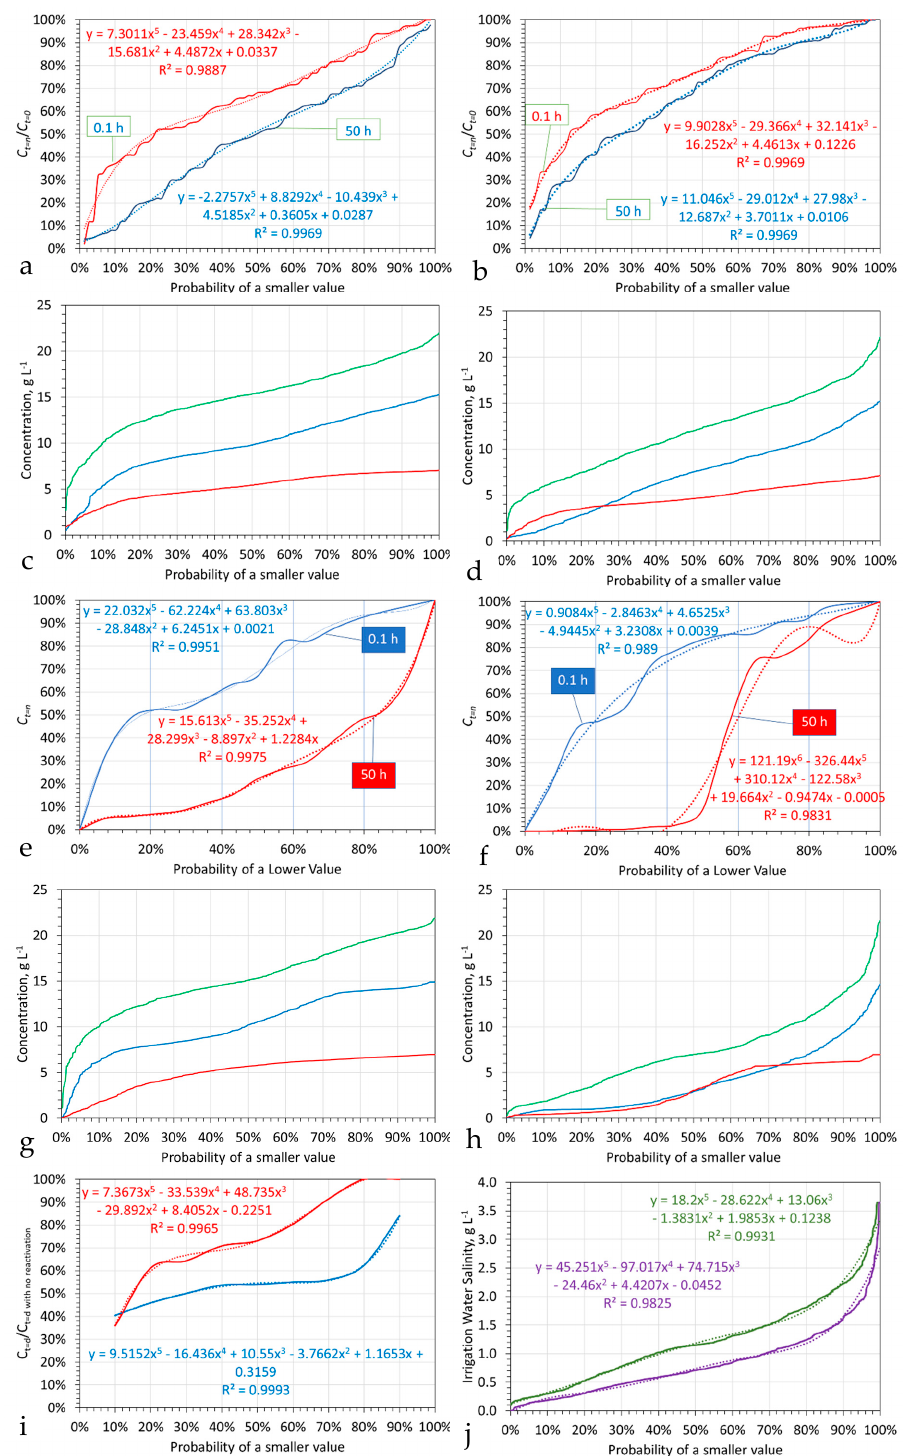
Figure 18. Desalination assessment: Generic Observed Ion Removal : Probability of a smaller value versus C t = n / C t =0 versus probability for t = 0.1 h (red) and t = 50 h (blue) with the associated polynomial equations, and ( a ), chloride; ( b ), sodium; Monte Carlo Modelling: Modelled concentration (g L − 1 ) versus probability for the flowback water in Trial 1 (Table 1) following metal polymer treatment. ( c ), t = 0.1 h; ( d ), t = 50 h; Red = sodium; Blue = chloride; Green = NaCl. Number of